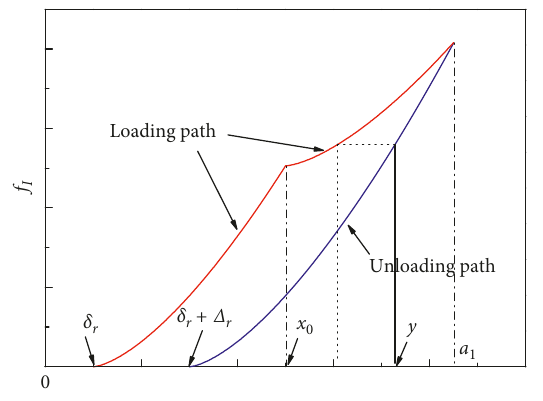
Figure 2: The constitutive relationship of the modified Hertzian contact model.